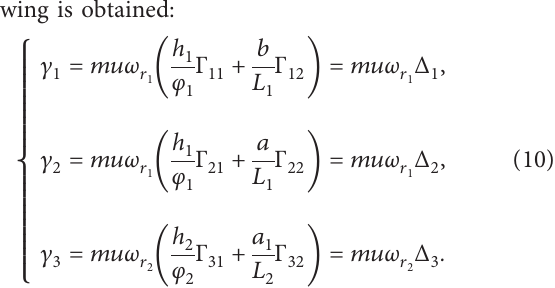
Figure 3: Force analysis diagram under steering